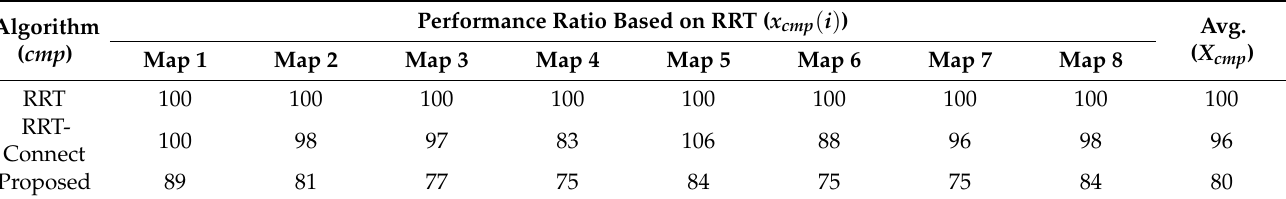
Table 11. Experimental results in total on the average path length (%).